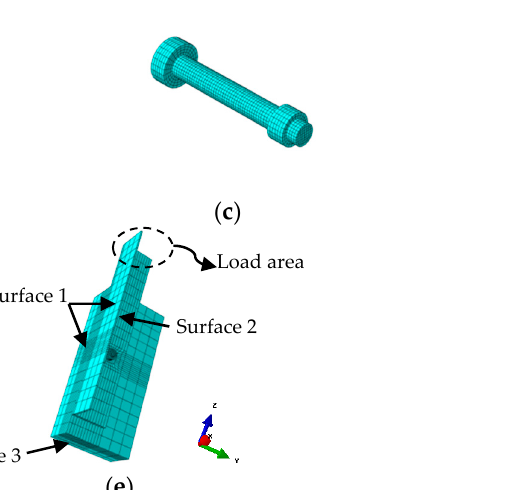
Figure 4. Mesh generation of the finite element model (FEM): ( a ) concrete plate; ( b ) steel beam; ( c ) bolted connector; ( d ) steel cage; ( e ) model.2.3. Material Modeling.